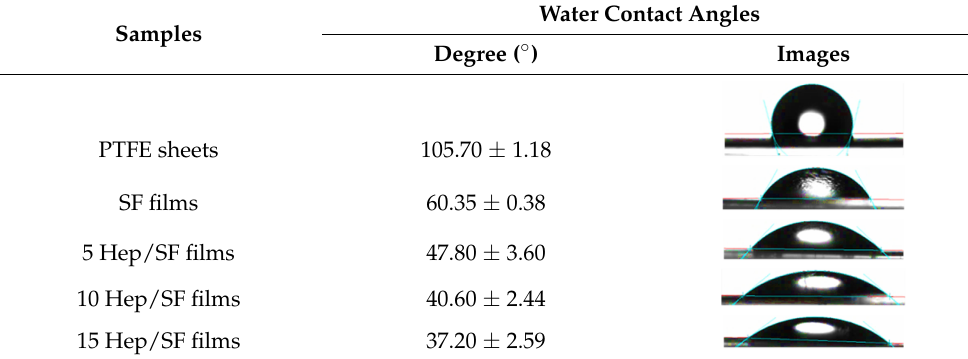
Table 2. Water contact angles of silk fibroin (SF) and heparin-silk fibroin (Hep/SF) films compared to